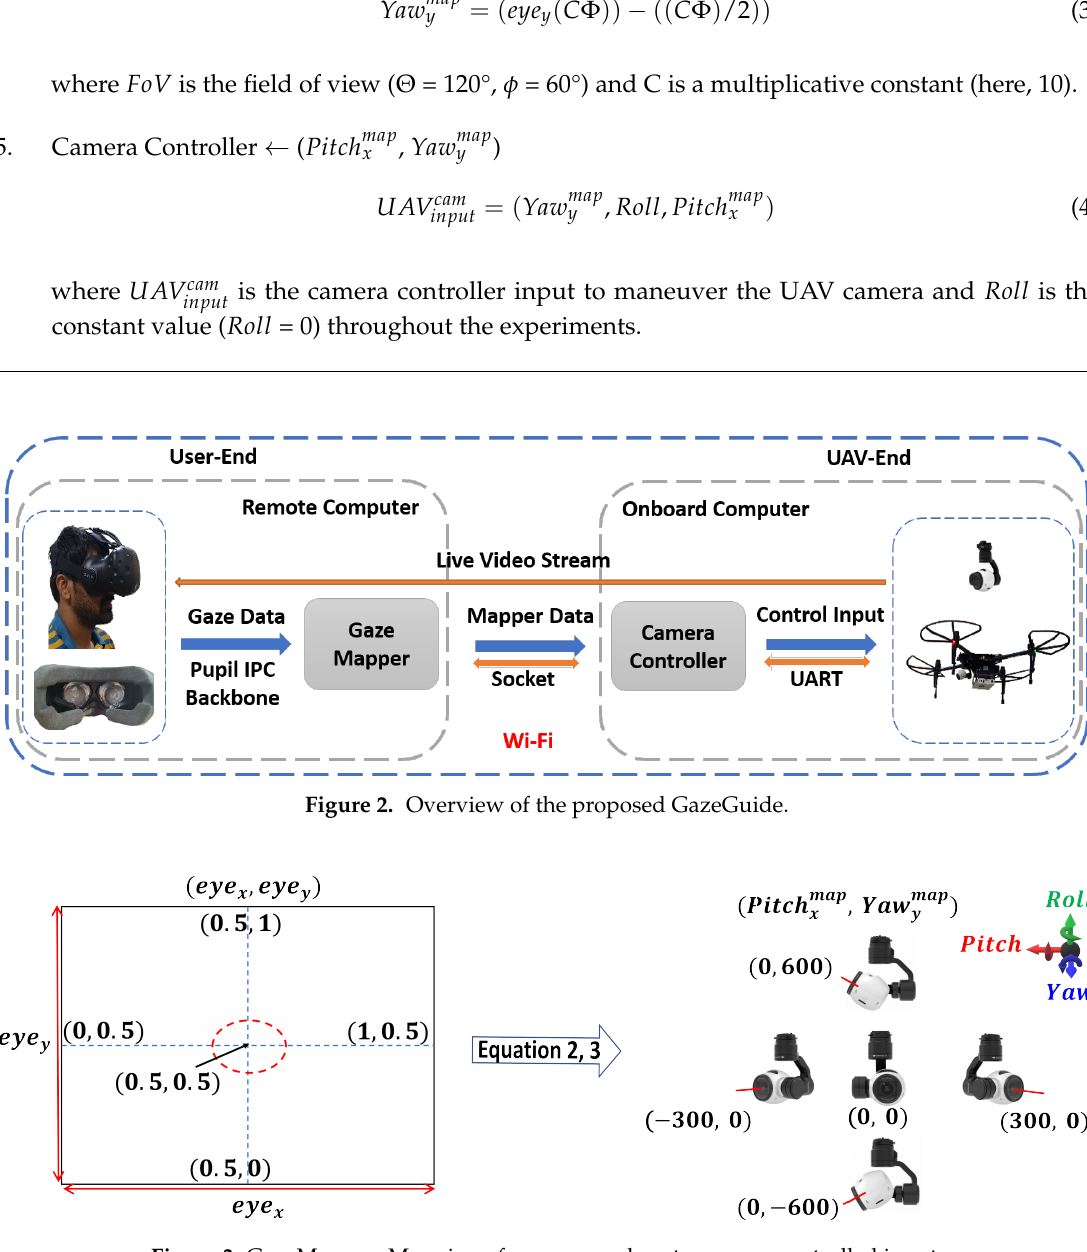
Figure 3. GazeMapper: Mapping of eye-gaze values to camera-controlled